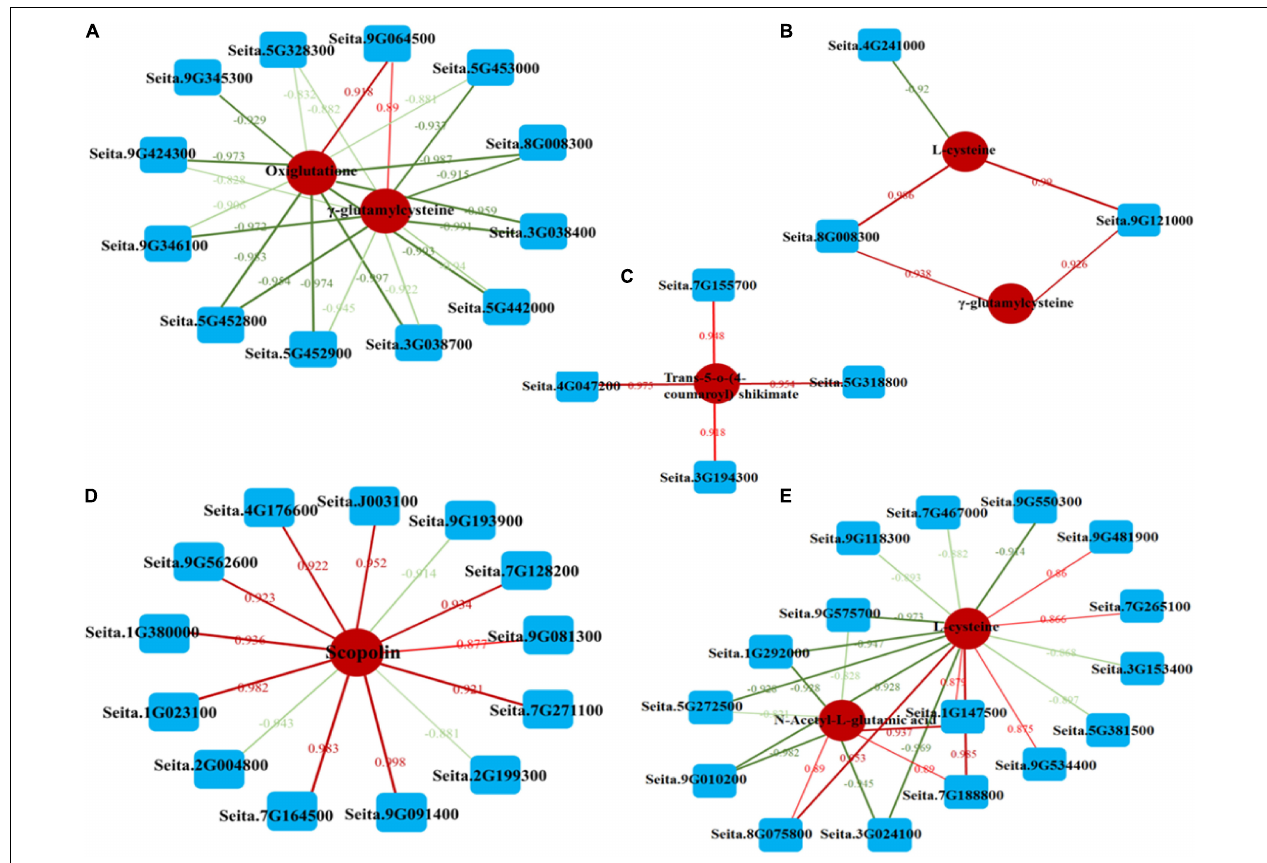
FIGURE 4 | Coexpression analysis of DEGs and DEMs based on Pearson’s correlation. (A,B) Interaction network of DEGs and DEMs involved in glutathione biosynthesis (ko00480) in GCK vs. GT and LCK vs. LT. (C,D) Interaction network of DEGs and DEMs involved in phenylpropanoid biosynthesis (ko00940) in GCK vs. GT and LCK vs. LT. (E) Interaction network of DEGs and DEMs involved in amino acid biosynthesis (ko01230) in LCK vs. LT. Lines colored in “red” and “green” display positive and negative correlation, respectively, according to Pearson’s correlation coefficient of > 0.8 or < –0.8, respectively.